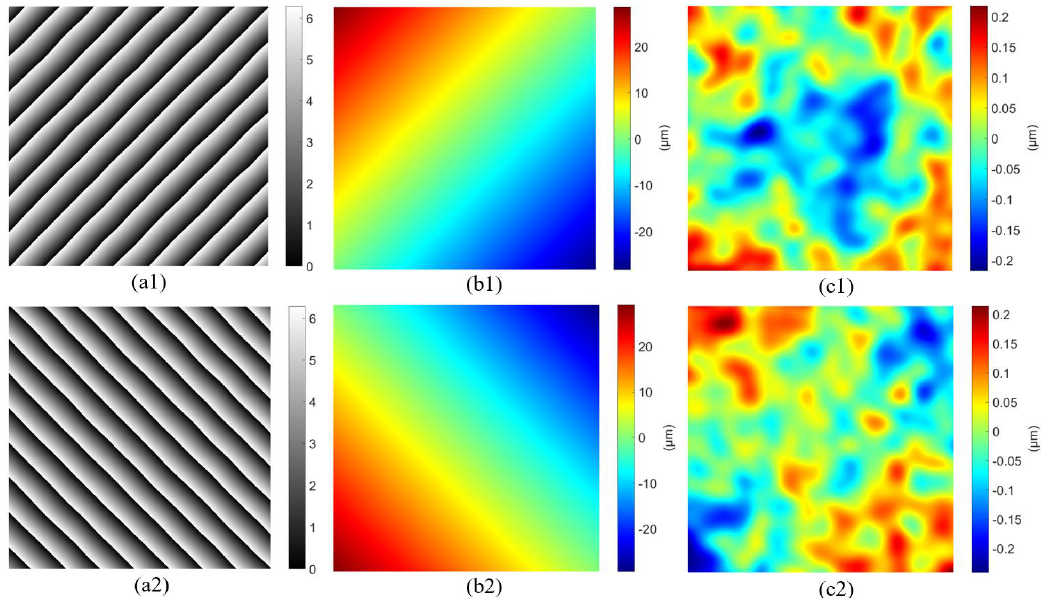
Figure 8. The smoothed phase and in-plane displacement extracted by the DSPI: ( a1 ) and ( a2 ) are the phase di ff erences ∆ x , and ∆ y , respectively; ( b1 ) and (b2 ) are in-plane displacements in the x-axis direction and y-axis direction respectively; ( c1 ) and ( c2 ) are in-plane displacements errors in the x-axis direction, and y-axis direction, relative to the fitted value, respectively.